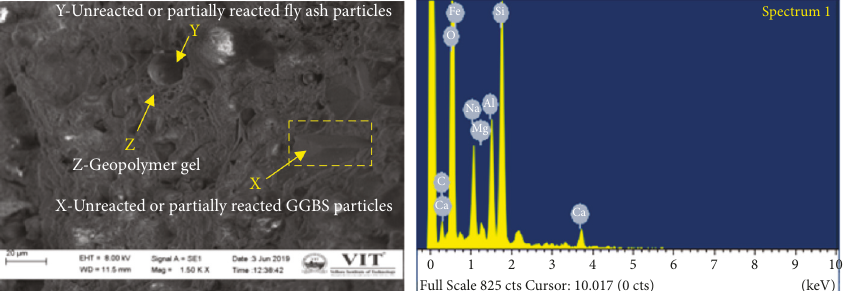
Figure 6: SEM image and EDX spectrum of mix GC3 (G20M100).